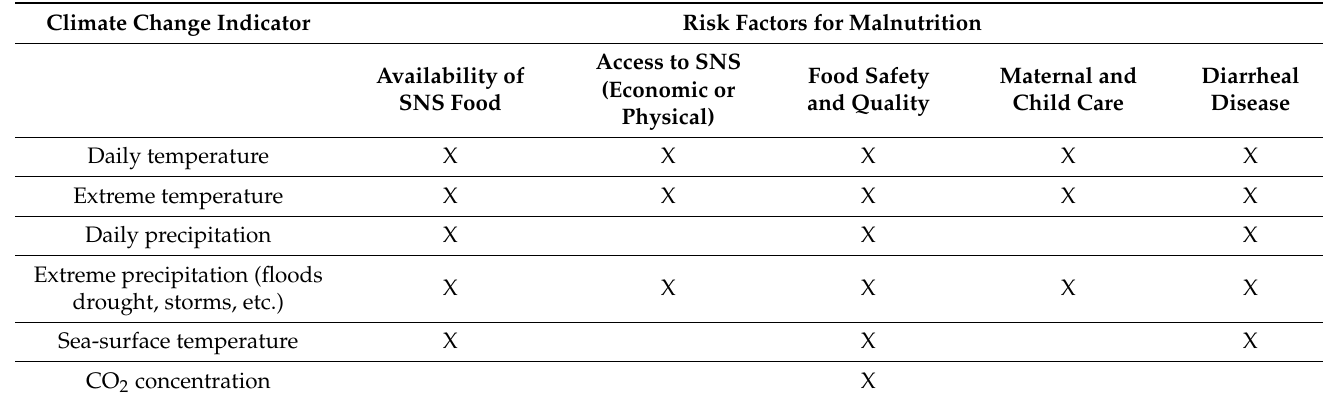
Table 2. Links between climate change indicators and risk factors for